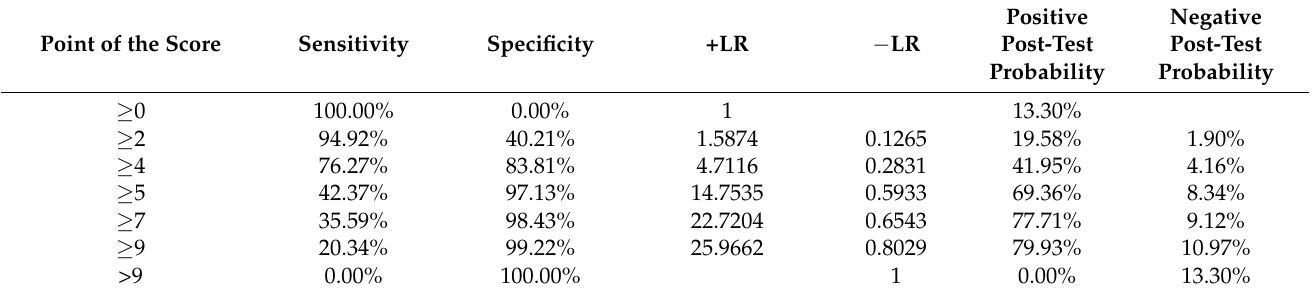
Table 4. Sensitivity, specificity, and post-test probability of the different cut-off points of the